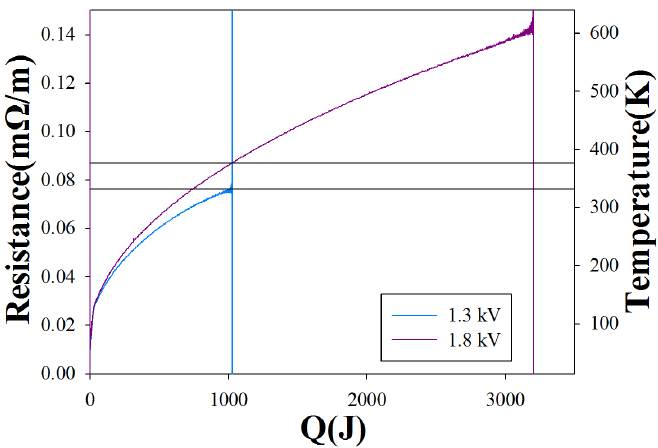
Figure 9. Typical R–Q curves of sample 4 under impact.